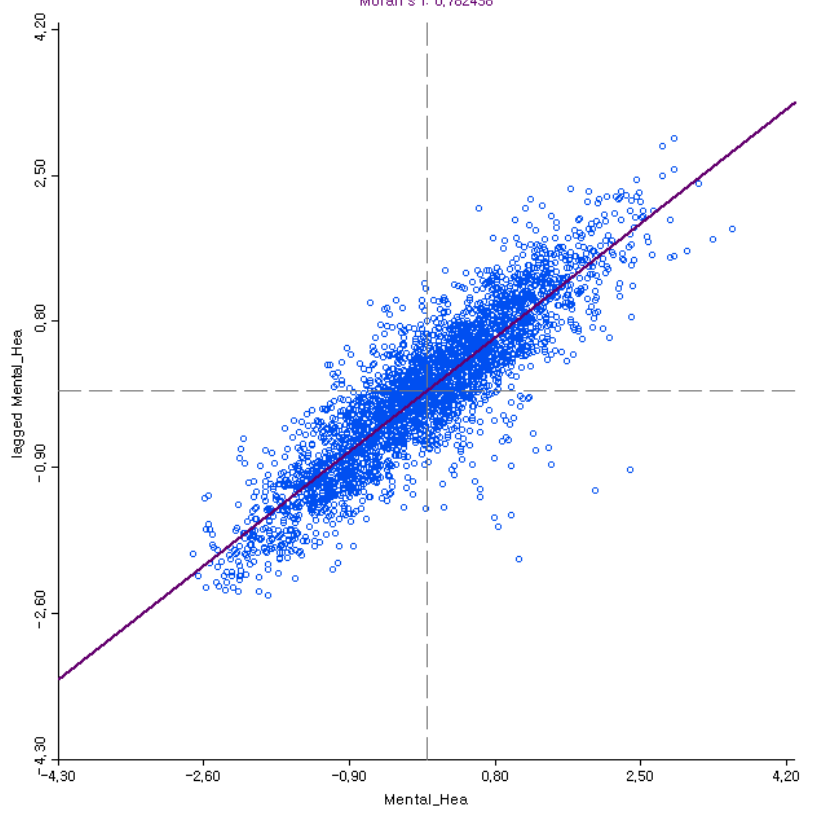
Figure 1. Results of global Moran’s I test.